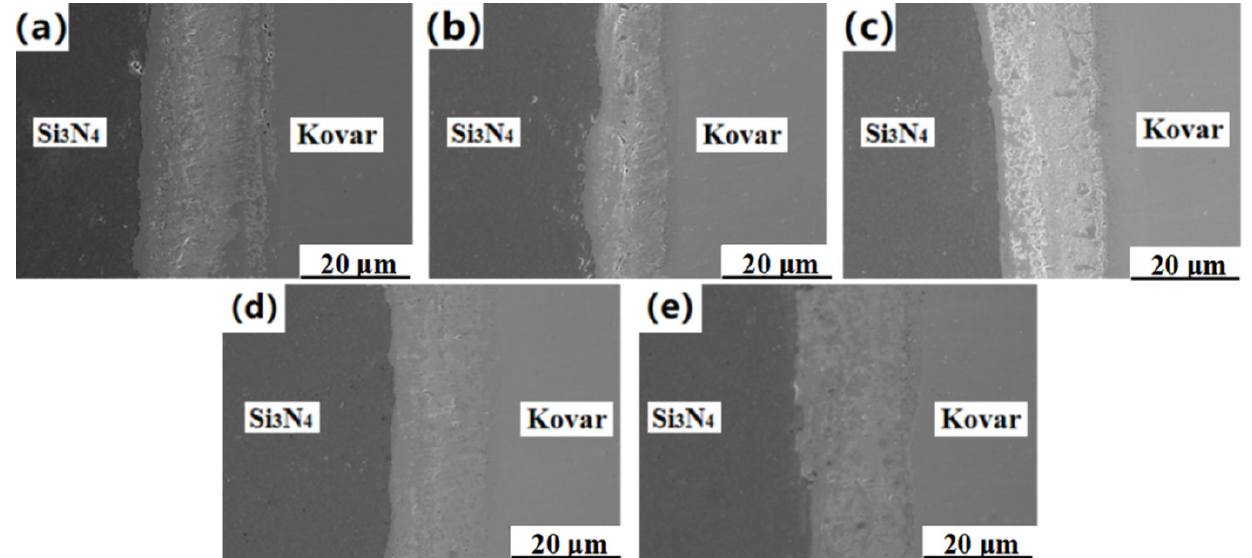
Figure 6. The microstructure of Si 3 N 4 /Ti/Cu/Kovar joints at ( a ) 940 °C, ( b ) 970 °C, ( c ) 1000 °C, ( d ) 1030 °C and ( e ) 1060 °C.